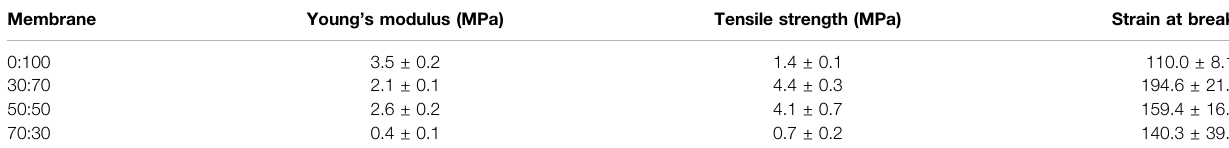
TABLE 2 | Mechanical parameters calculated from the strain-stress curves of wet membranes. Membrane